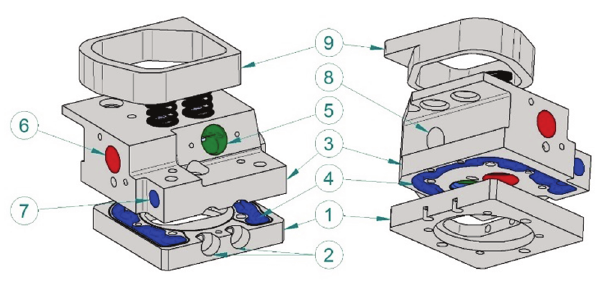
Fig. 2. Prototype cylinder head: 1 – lower part with combustion chamber and water jacket, 2 – injector seats, 3 – middle part, 4 – water jacket, 5 – intake channel, 6 – exhaust channel, 7 – cooling system inlet, 8 – spark plug socket, 9 – upper